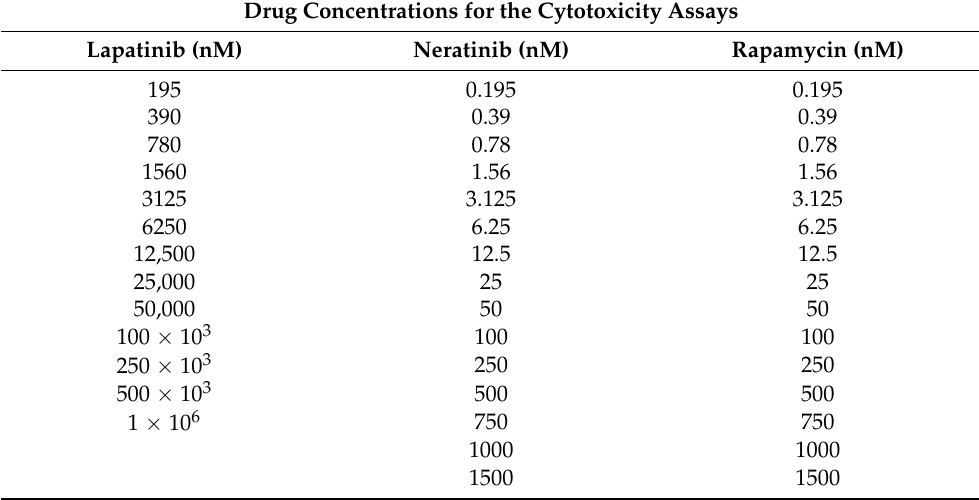
Table 1. Concentrations of lapatinib (nM), neratinib (nM) and rapamycin (nM), used in the cytotoxic- ity assays. Cells were exposed to drugs for 72 h before cytotoxicity evaluation. Drug Concentrations for the Cytotoxicity